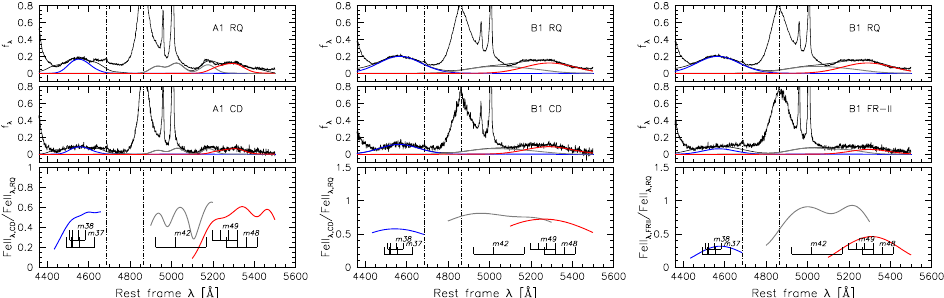
Figure 7. Non-linear χ 2 multi-component analysis with a Fe II template with relative multiplet intensity free to vary. Colours as in Figure 6.